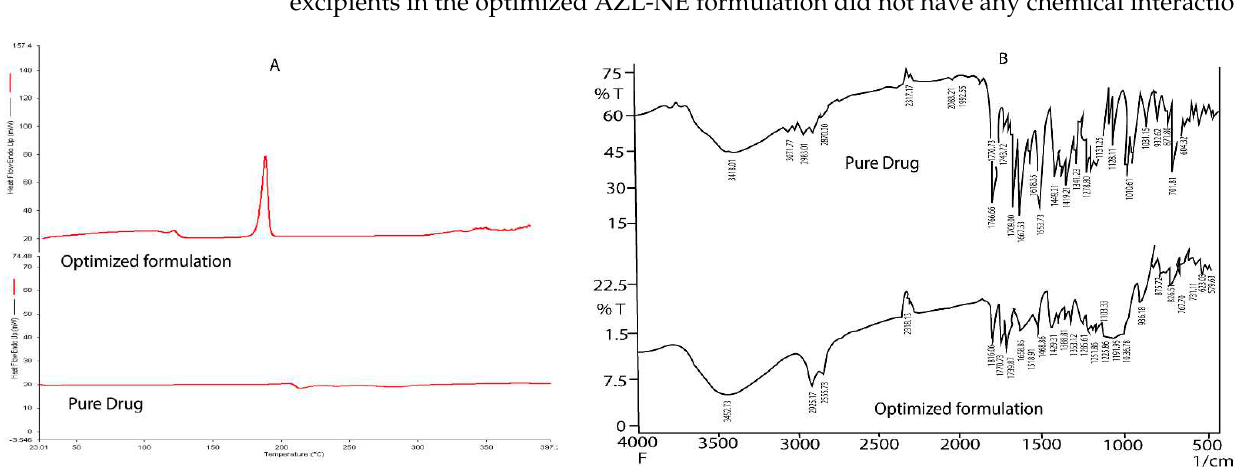
Figure 7. ( A , B ) depict DSC thermograms and FTIR spectrum for pure drug and optimized AZL-NE formulation, respectively. formulation,